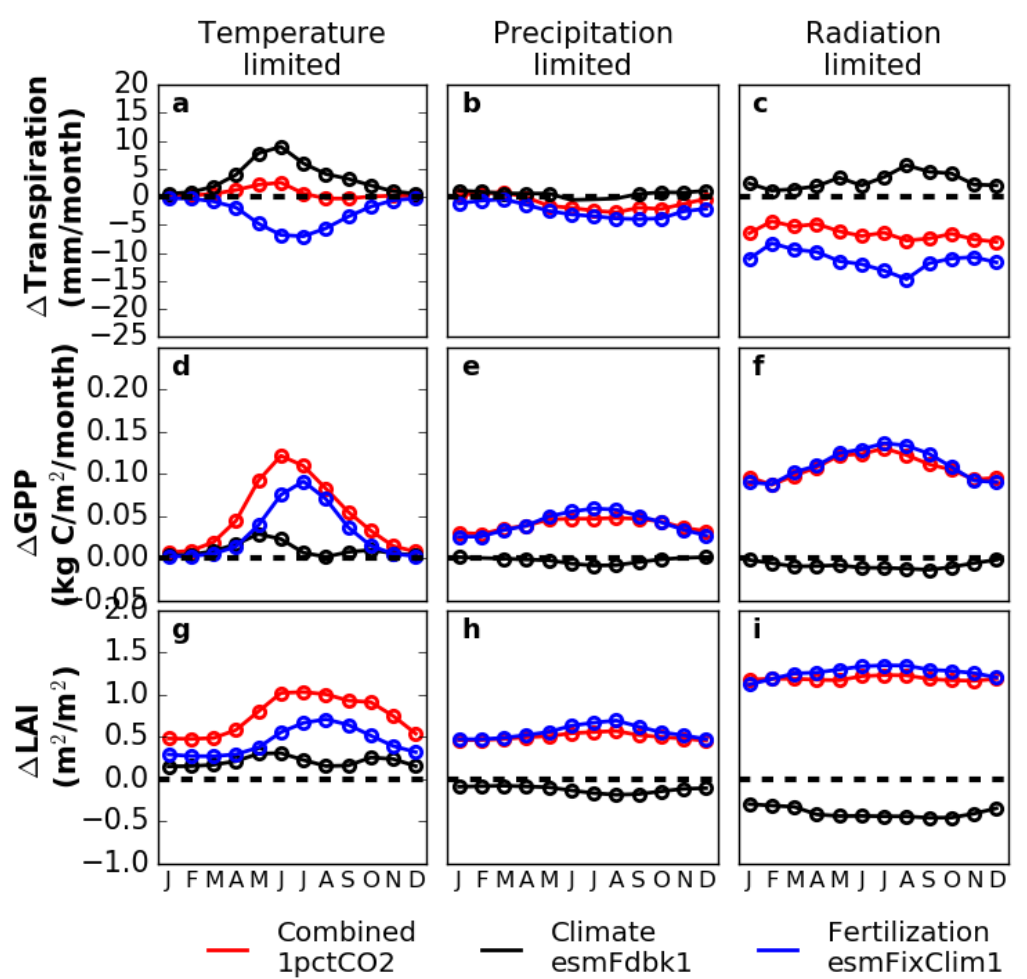
Figure 9. Additive and counteracting impacts of CO 2 on vegetation. Same as Figure 7 except for transpiration, a – c ; GPP, d – f ; and LAI, g – i .